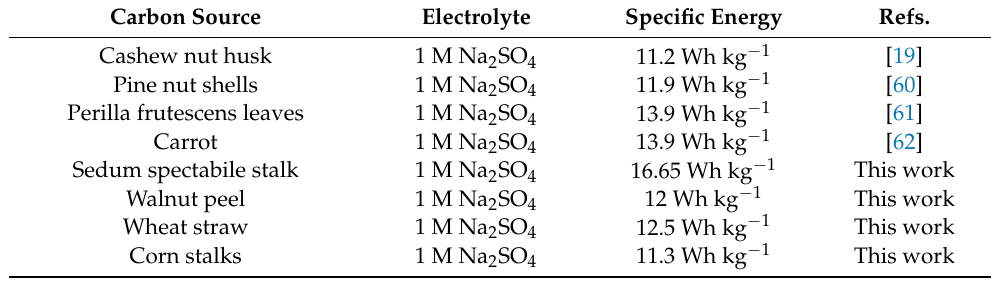
Table 3. Comparison of the specific energy value of the supercapacitor with biomass carbon in recent